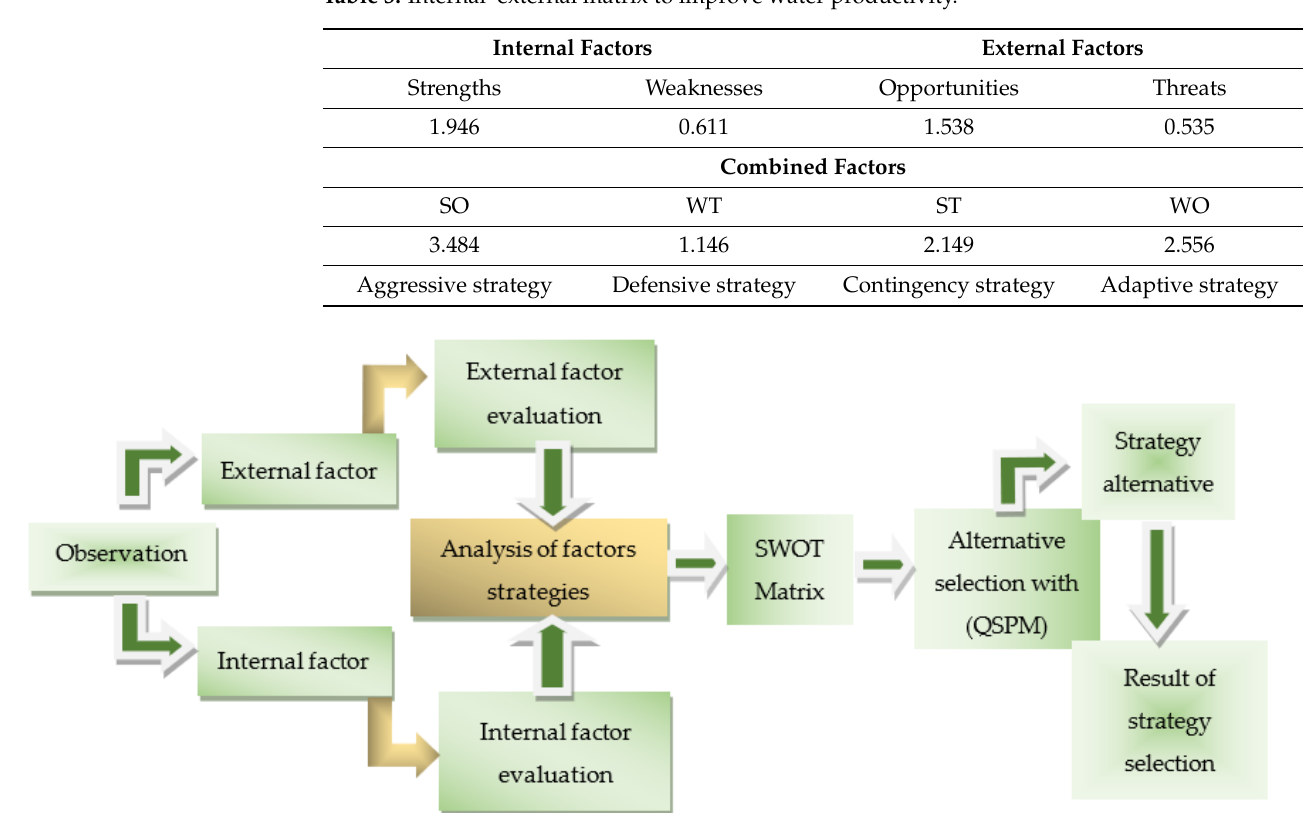
Table 3. Internal–external matrix to improve water productivity.